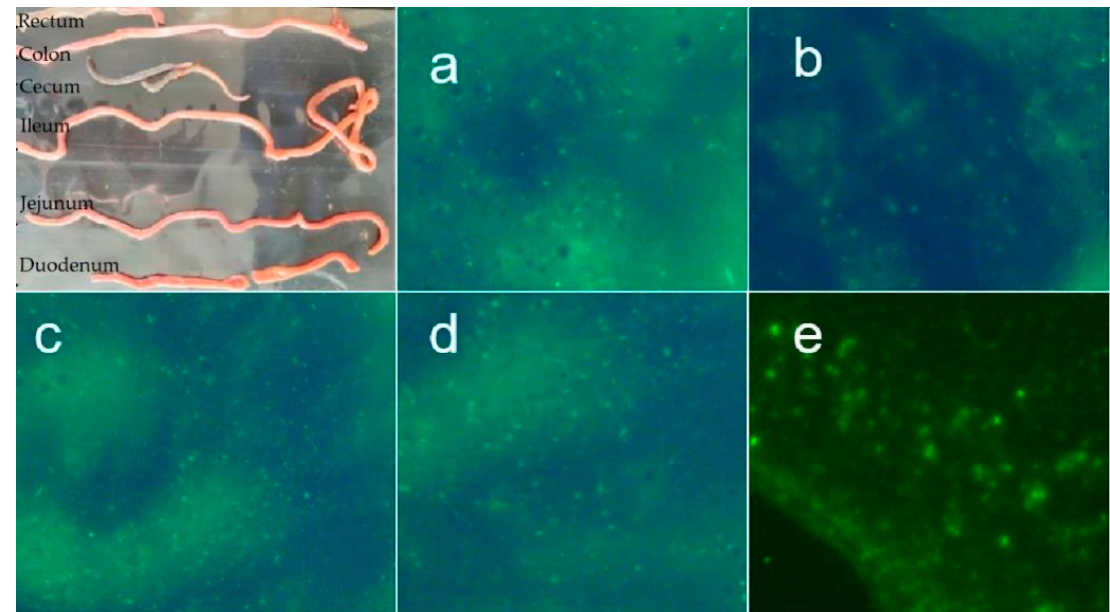
Figure 7. Fluorescence microscopy of intestinal mucosal epithelial contents: ( a ) duodenum; ( b ) jejunum; ( c ) ileum; ( d ) cecum; ( e ) colon.